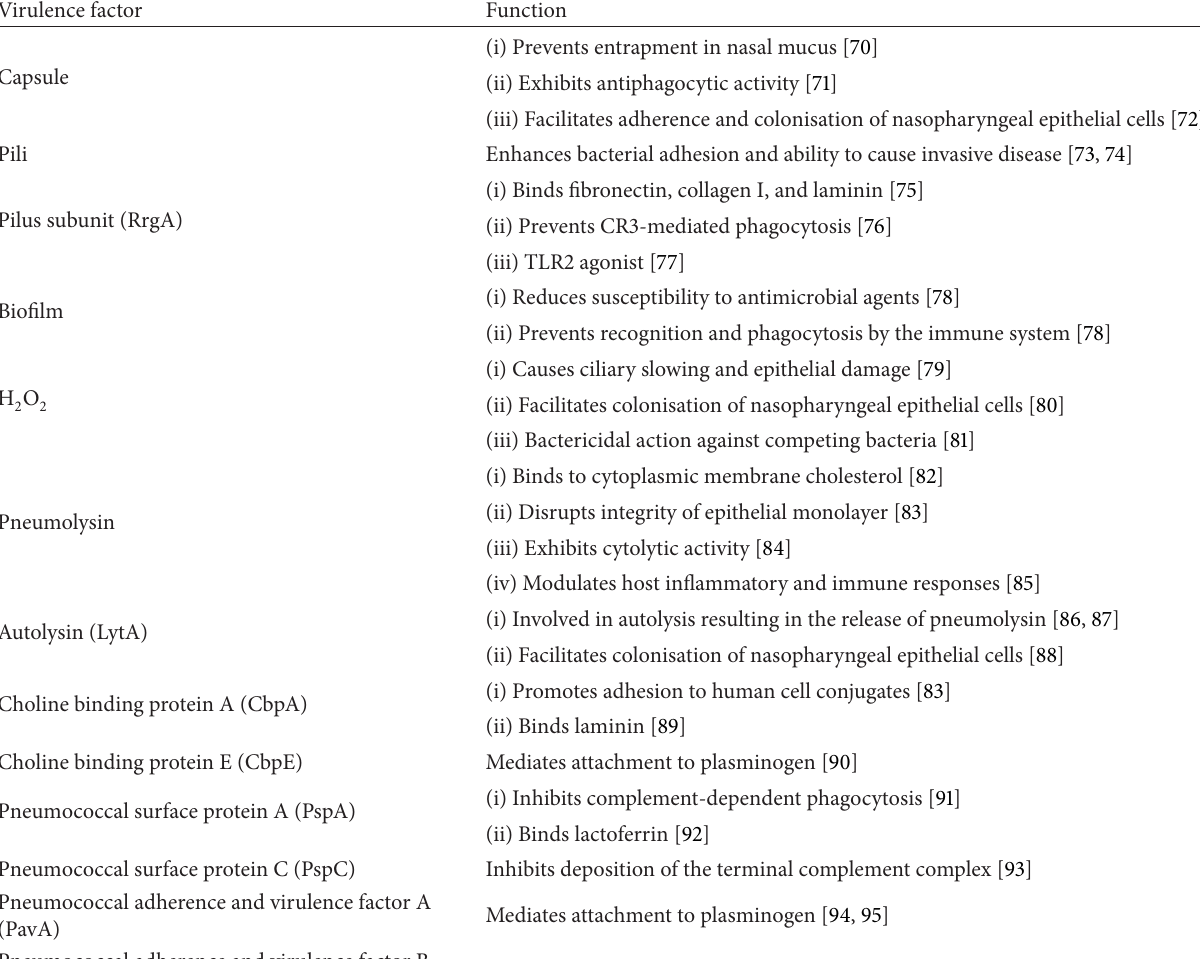
Table 1: Virulence determinants of S. pneumoniae and mechanisms of subversion of host